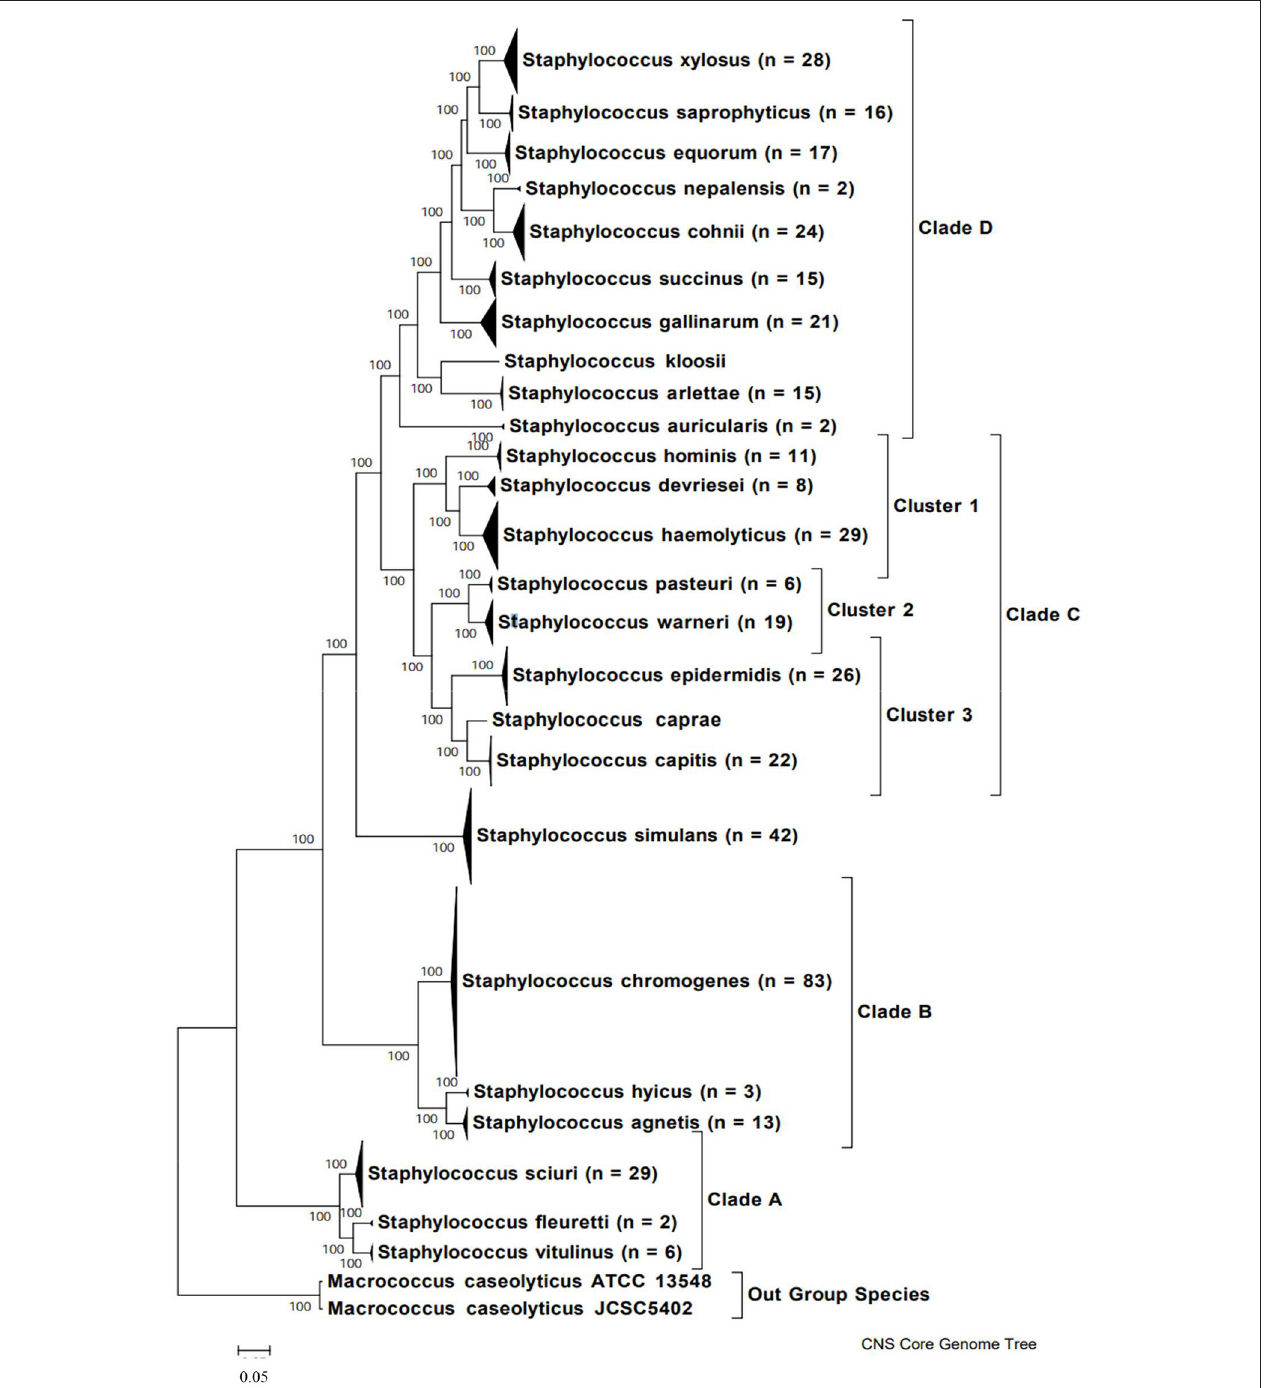
FIGURE 1 | Phylogenetic tree of NAS species based on whole genome sequences, indicating major clades. Copied from Naushad et al.